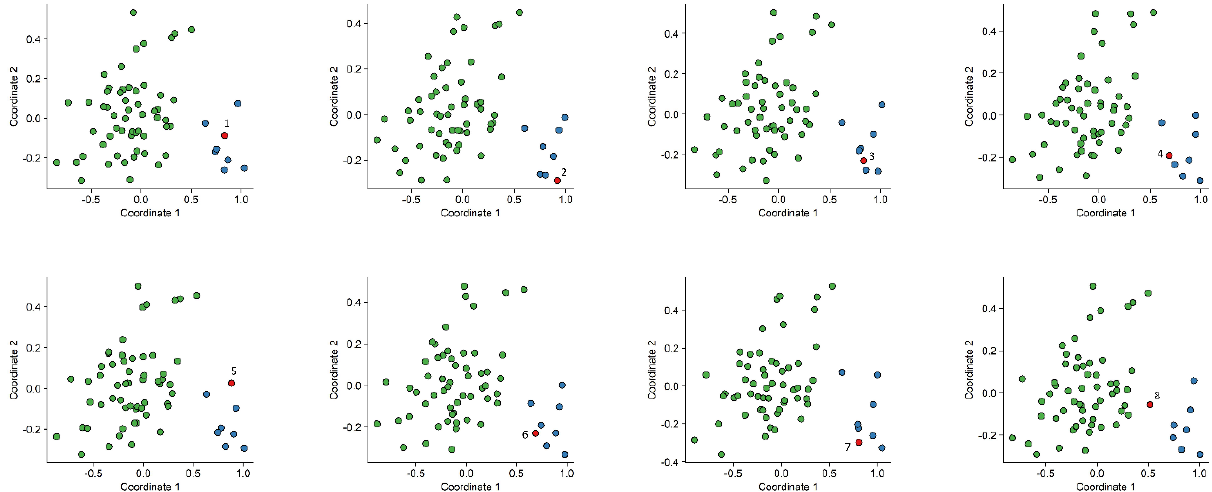
Figure 4. Multidimensional scaling (MDS) plots generated after eight rounds of “leave one out” cross-validation. X -axis represents coordinate 1 and Y -axis represents coordinate 2, leaving one case sample for testing (annotated in red) at each round. Control samples are annotated in green and patient samples annotated in blue. Robust clustering of the test patient with discovery patients was observed.